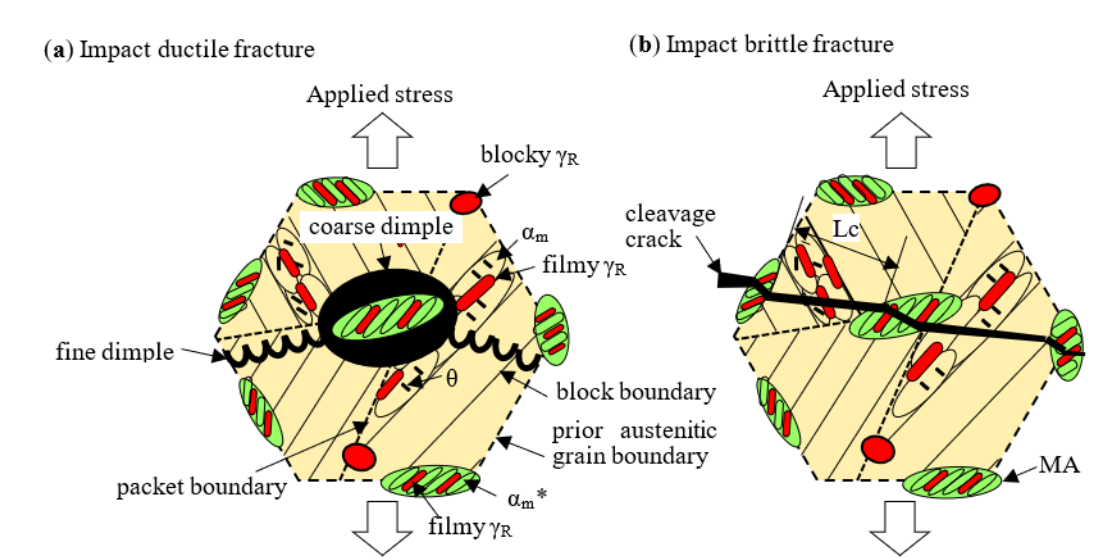
Figure 9. Illustrations showing ( a ) ductile fracture and ( b ) brittle fracture of TM steel appeared on impact tests [74]. L c: Quasi-cleavage length affected by the MA phase located on prior austenitic, packet, and block boundaries. α m , α m *, γ R , θ , and MA represent coarse lath-martensite, fine lath/twin-martensite, retained austenite, carbide, and MA phase, respectively. Reprinted with permission from Springer Nature: Metall. Mater. Trans. A, Copyright 2021.